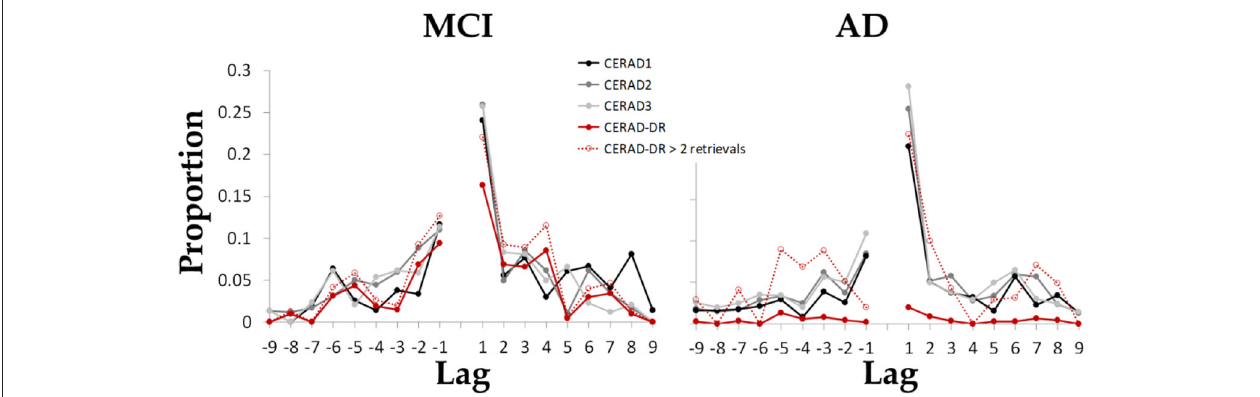
FIGURE 3 | The mean proportion of each possible transition between items as a function of the lag between items in the encoded wordlist. Results indicate that both groups maintained the tendency to retrieve items from nearby serial position of the just-recalled word, as well as the typical asymmetry reflected as greater proportion of forward transitions as compared to backward transitions. Dashed red line present data from a sub group of patients that retrieved at least two items during delayed recall ( N = 17 patients with AD, 26 patients with